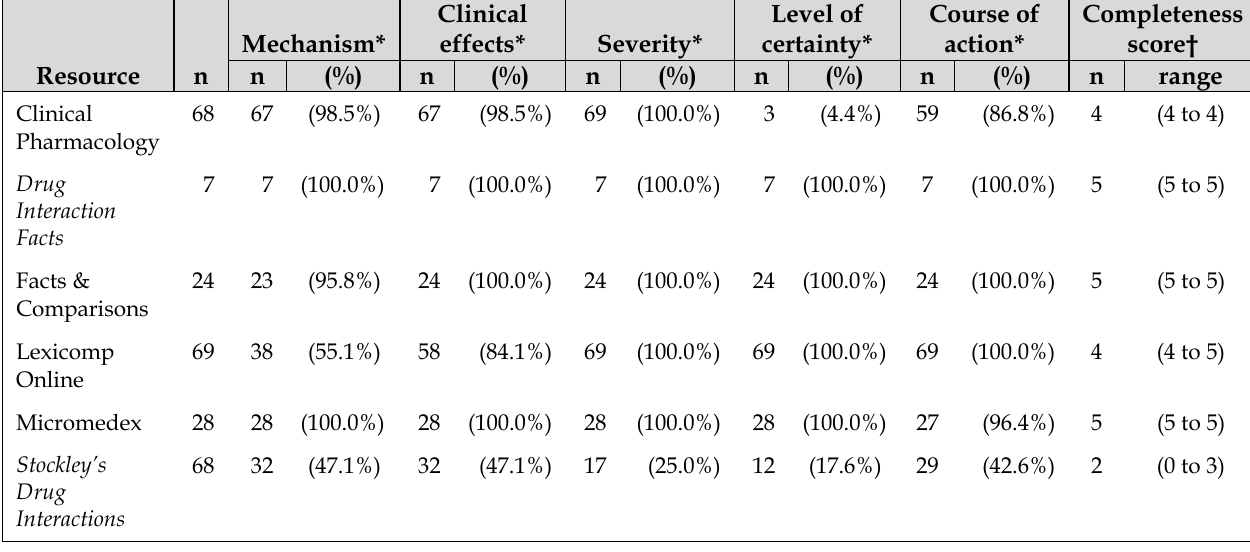
Table 2 Completeness elements and overall scores by